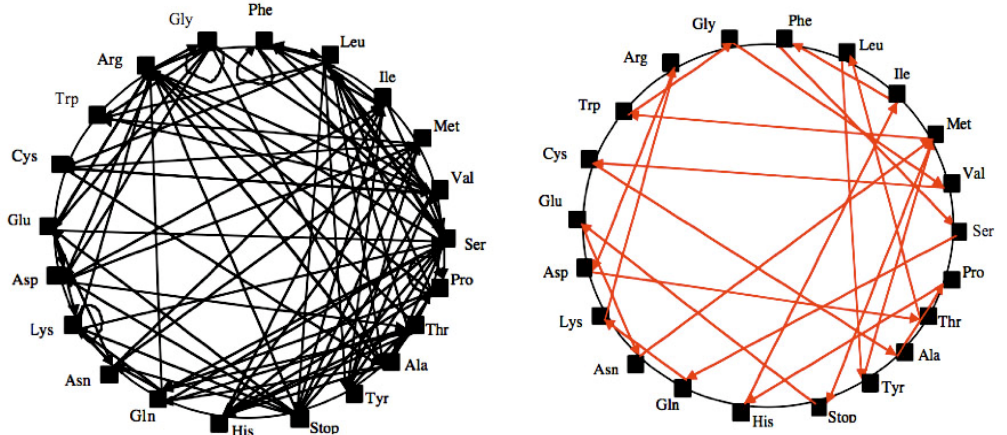
Figure 1. Search for a Hamiltonian circuit (it is a graph cycle through a graph that visits each node exactly once) on the graph of possible overlaps between synonymy classes of the genetic code (left) and a solution AB